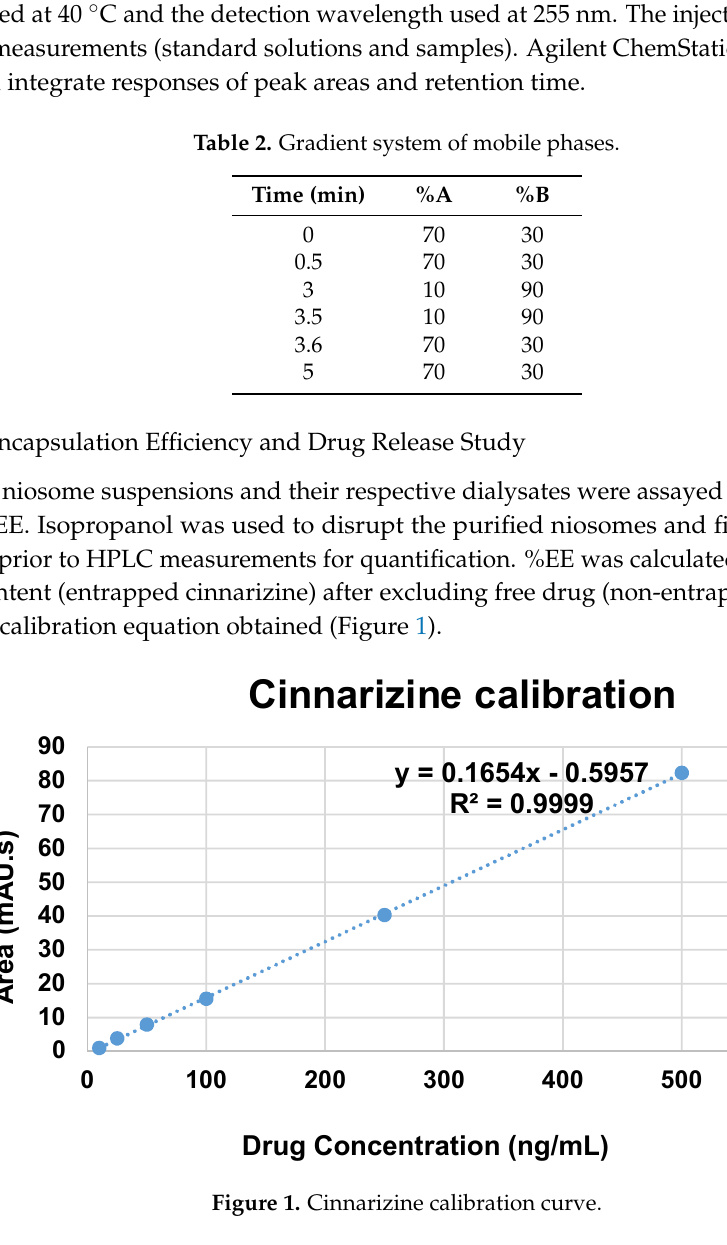
Table 2. Gradient system of mobile phases.